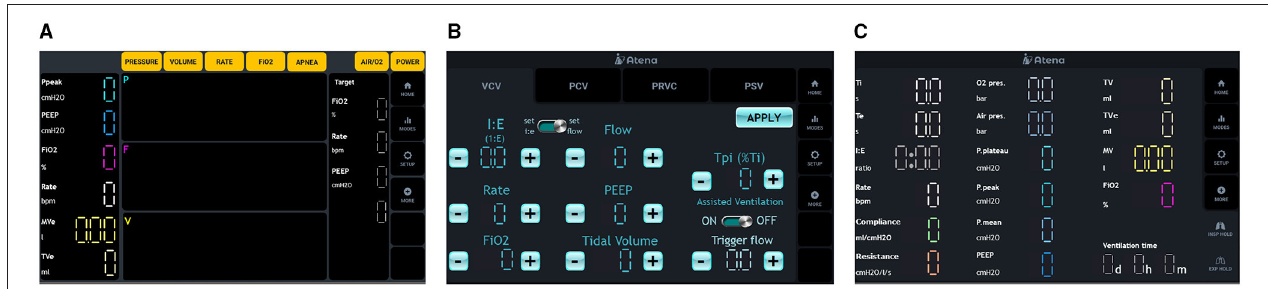
FIGURE 3 | ATENA Graphical User Interface. (A) Left panel, (B) central panel, and (C) right